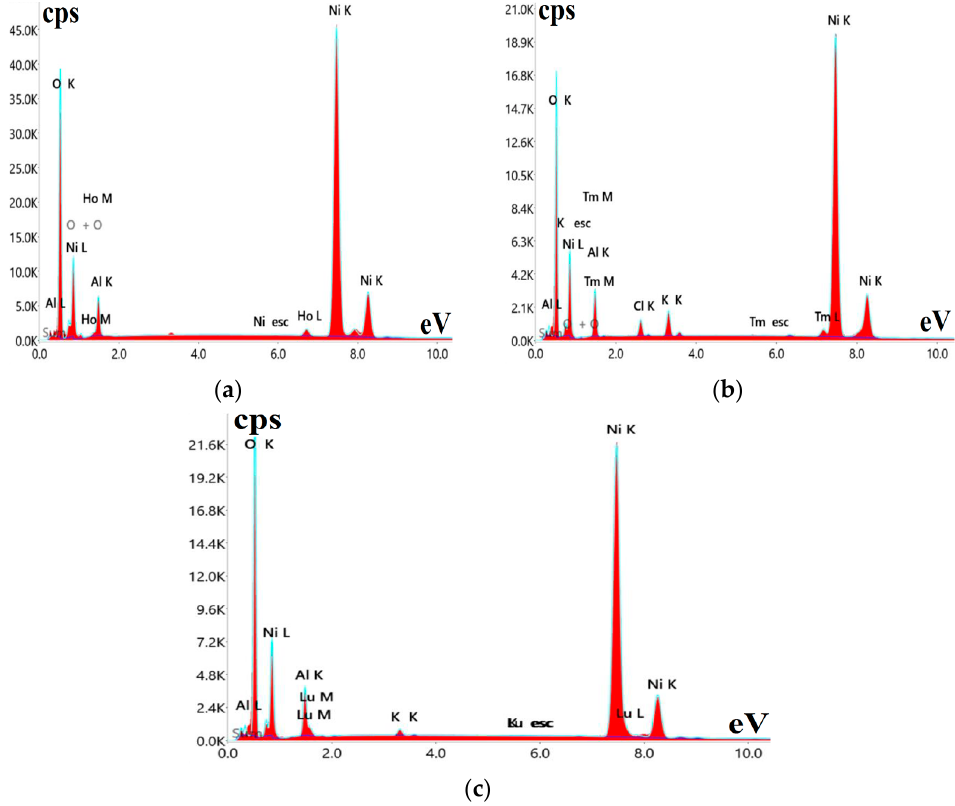
Figure 2. EDX spectra of as-synthesized lanthanide-containing layered double hydroxides: ( a ) Ni/AlHo; ( b ) Ni/AlTm; ( c ) Ni/AlLu. Table 1. Cationic molar ratios and lattice parameters of as-synthesized lanthanide-containing layered double